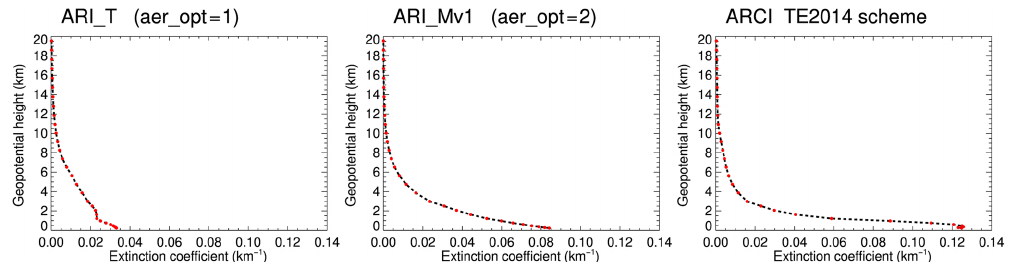
Figure 2. Annual mean of the domain-averaged vertical distribution of aerosol extinction coefficient at 550nm (km − 1 ) in each model layer (red dots) for the ARI_T (indicative of aer_opt = 1), ARI_Mv1 (indicative of aer_opt = 2) and ARCI (indicative of the TE2014 scheme)